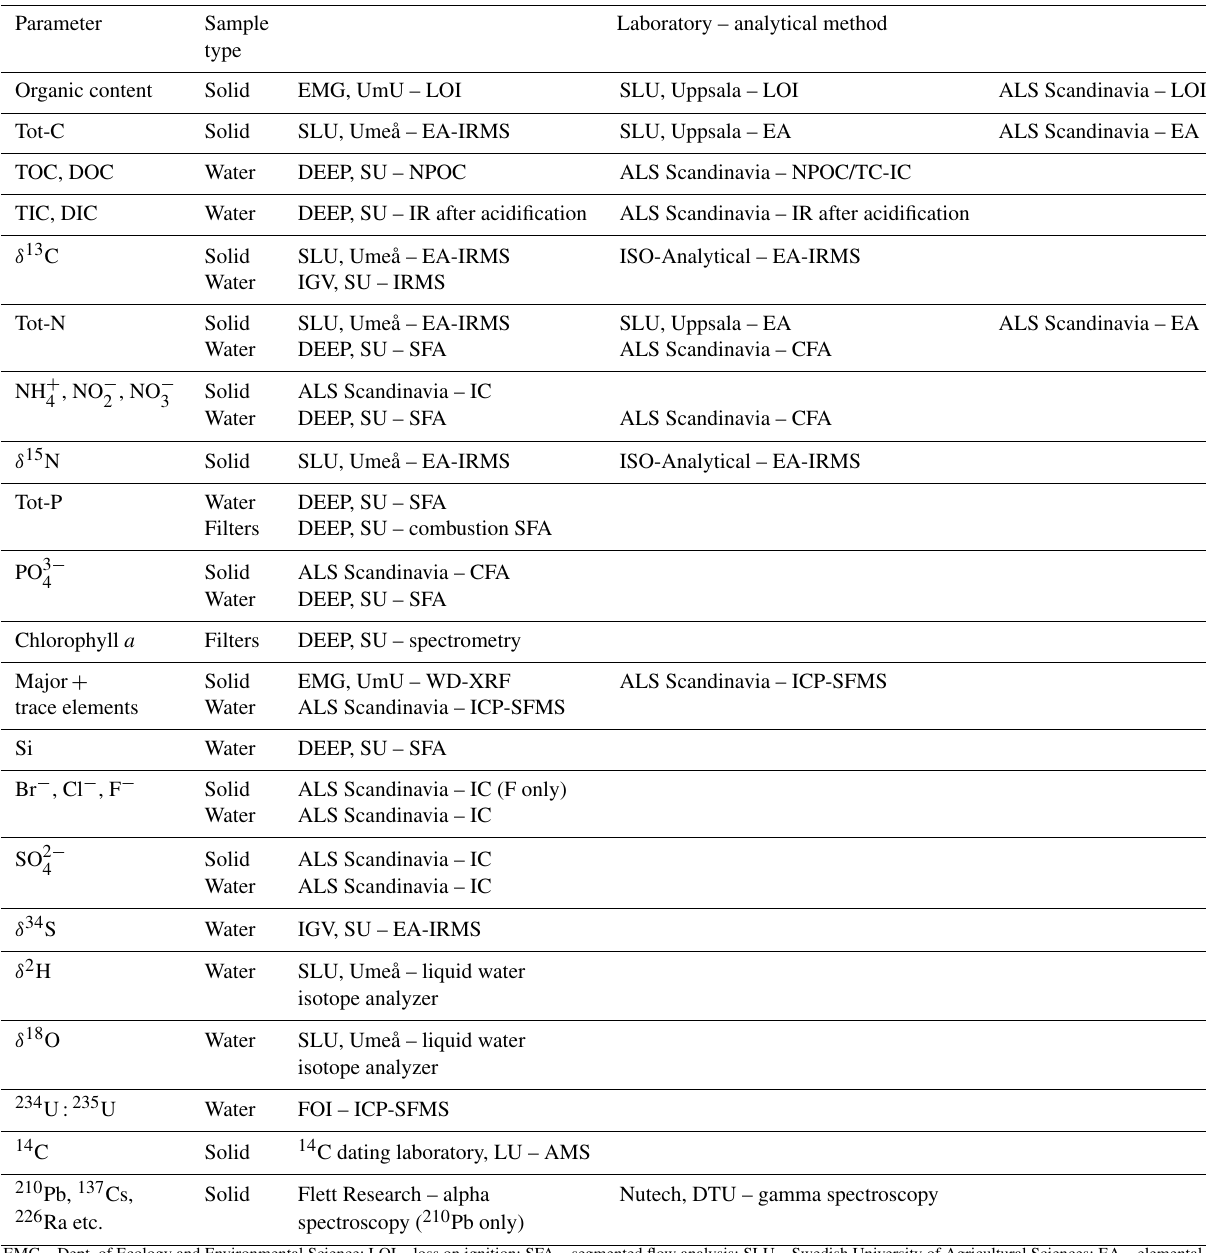
Table 2. Overview of the laboratories and analytical methods that have been used to produce the presented data set.